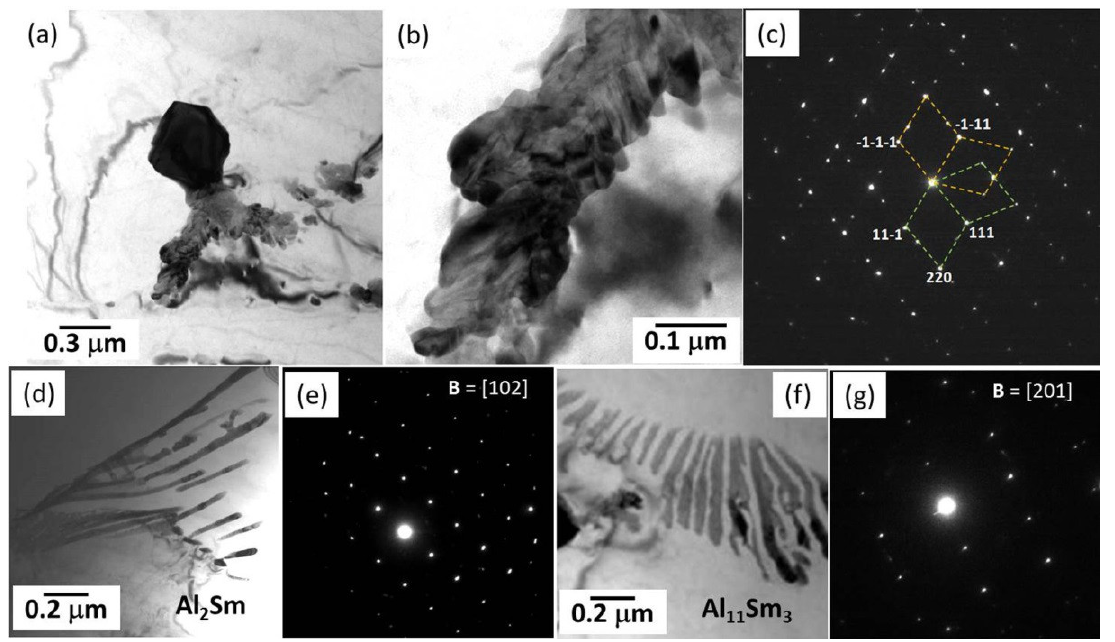
Figure 7. TEM images along with the corresponding SAED patterns of the intermetallic phases in Mg-Al-Sm-based alloys [86,87].